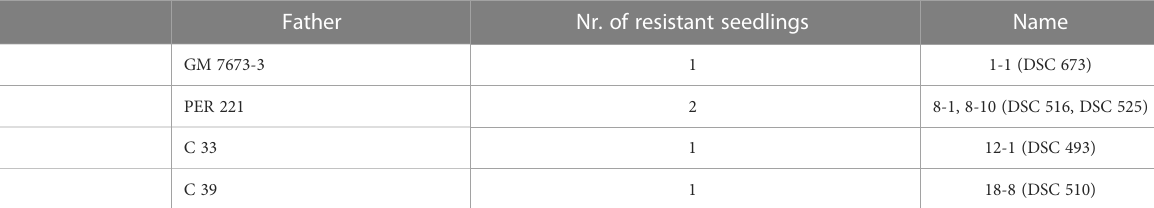
TABLE 4 Cassava seedlings (population 1) with resistance against viruses causing CMD x CBSD. Mother Father Nr. of resistant